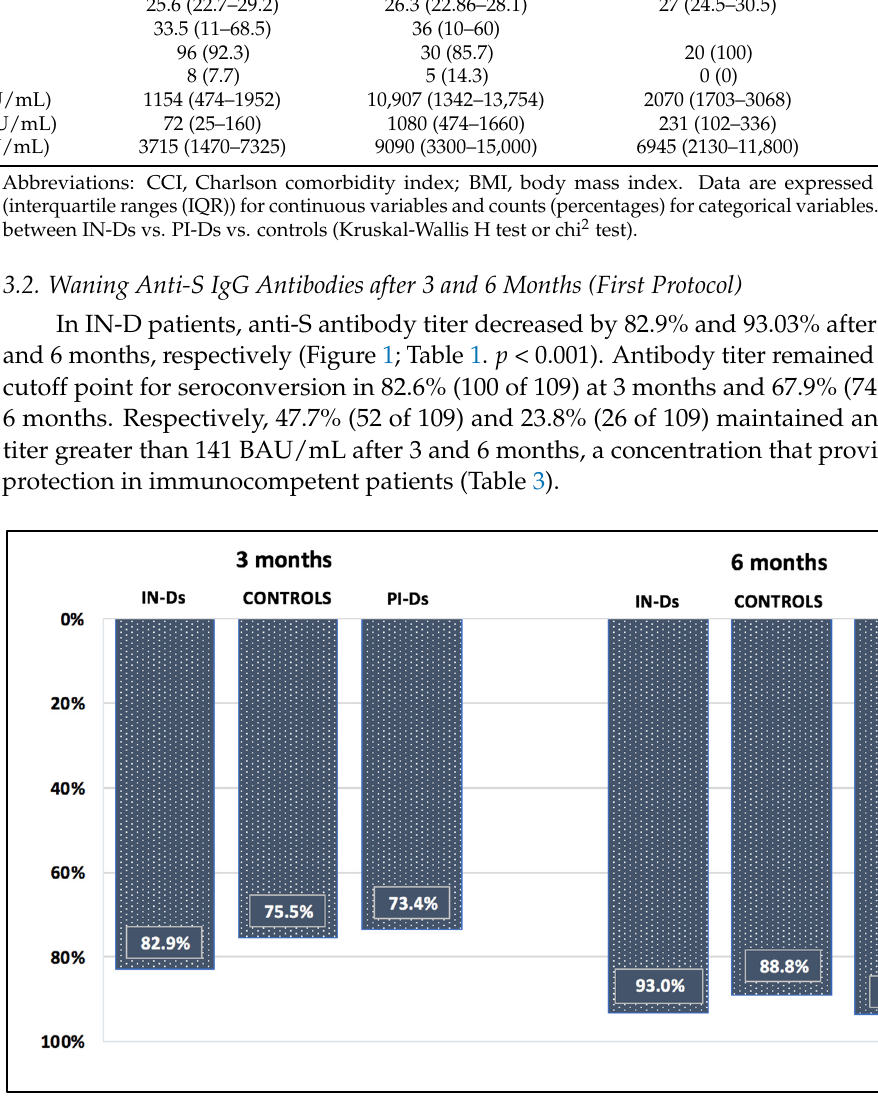
Figure 1. Anti-S IgG titer decline over time after second dose of vaccination. Table 3. Proportion of patients with anti-S antibody titer above the seroconversion cutoff point and the 141 BAU/mL threshold.